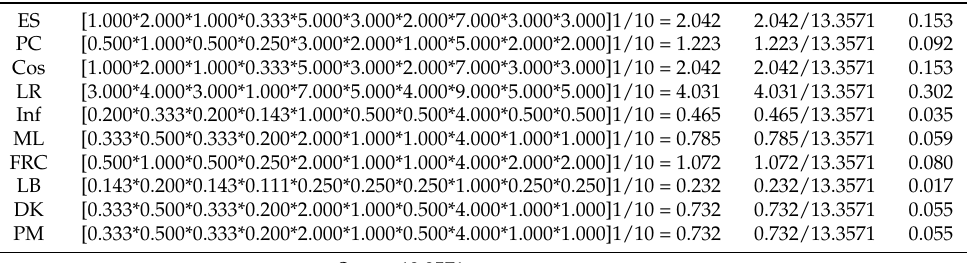
Table 6. Step by step calculations of criteria weight.